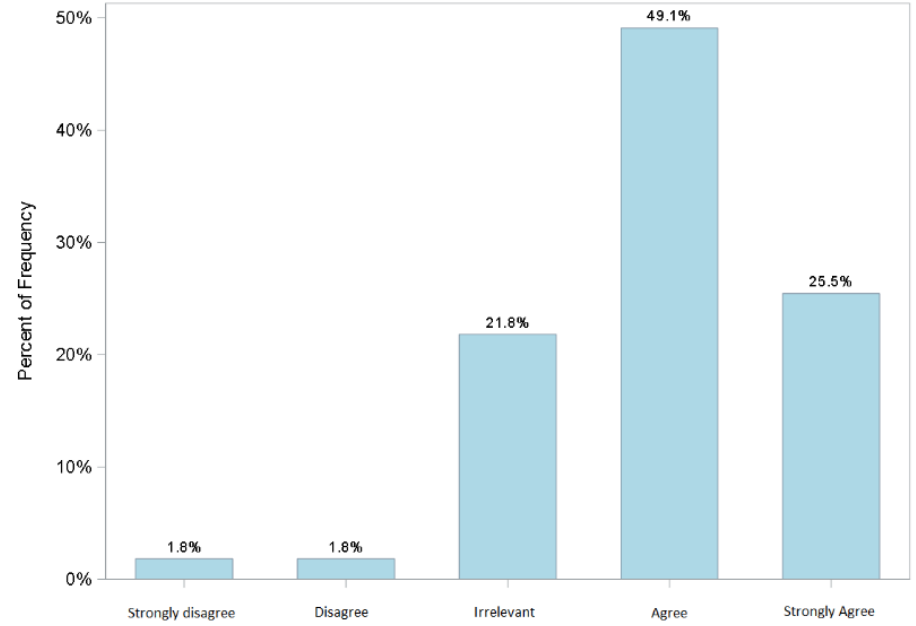
Figure 3. Q23. In the first few days after your access to the COVID-19 area, did you take isolation measures upon returning home to protect your family?